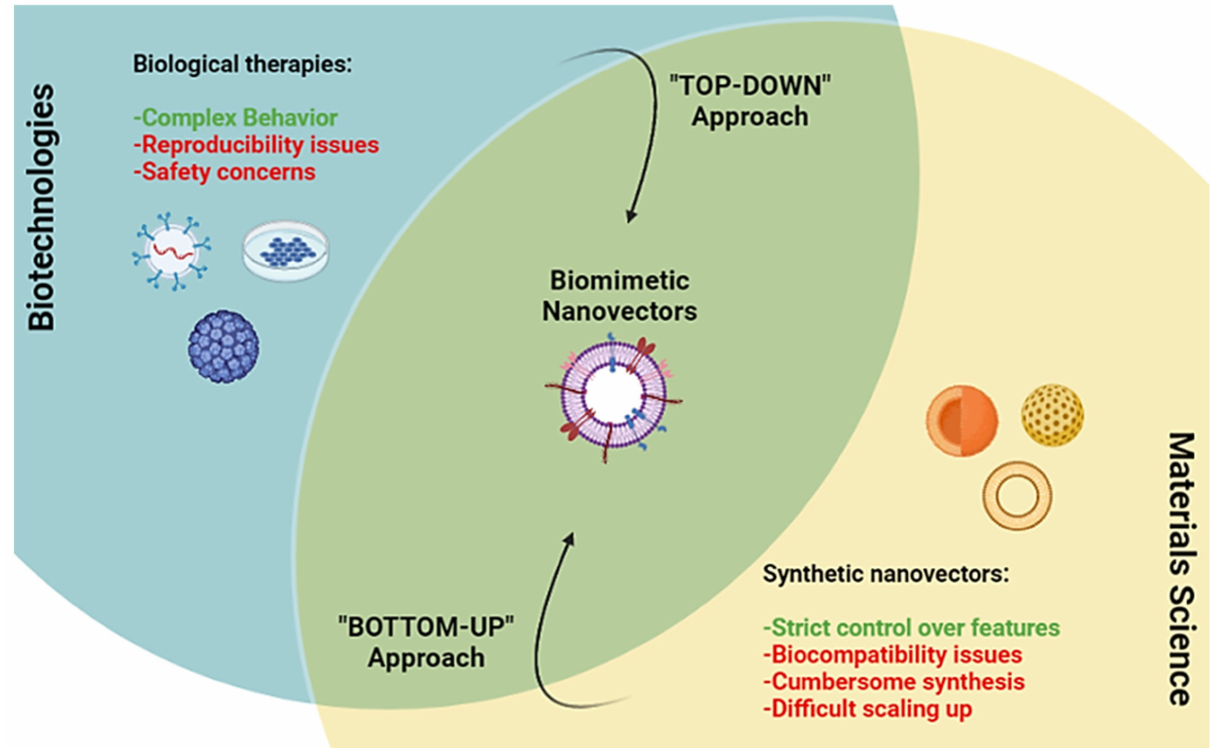
Figure 1. Schematic representation of how biomimetic nanovectors fit at the crossroads of biological therapies and synthetic nanovectors. For each field, its relative advantages are presented in green and disadvantages in red. This image was created using Biorender.com (accessed on 1 March